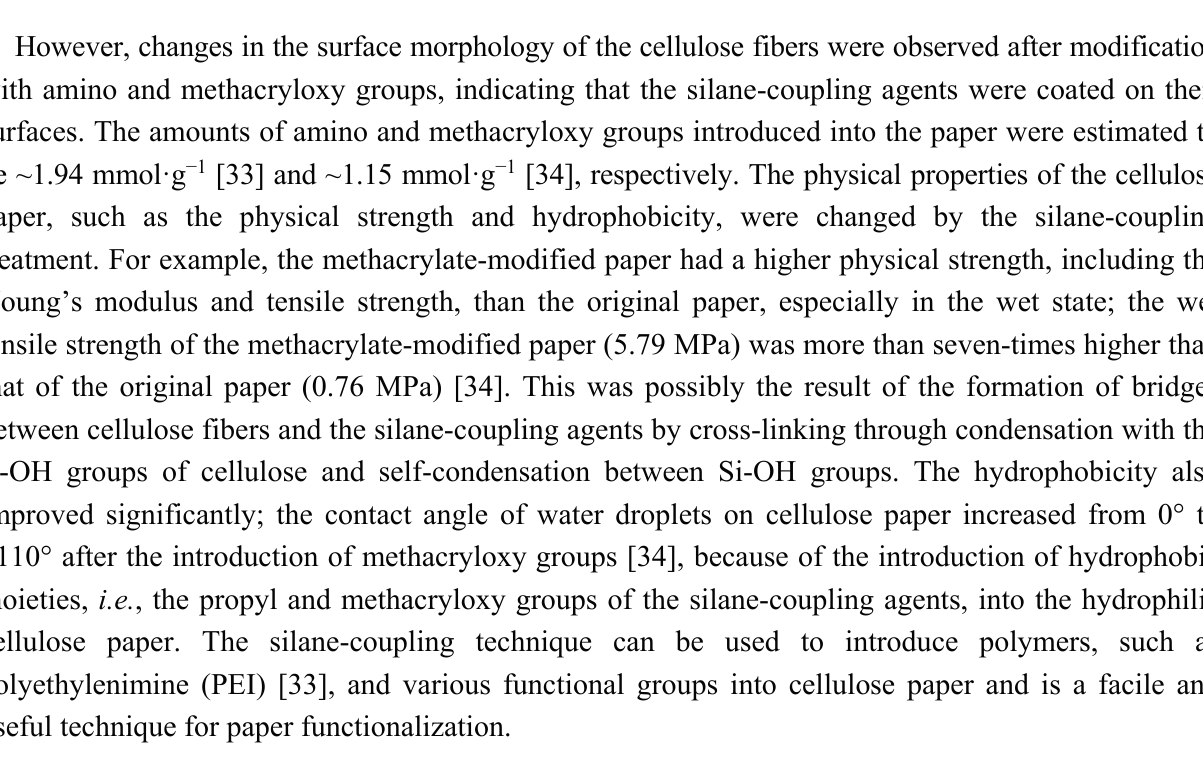
Figure 4. Field-emission scanning electron microscopy images of: ( a ) original paper; ( b ) amine-modified paper; and ( c ) methacrylate-modified